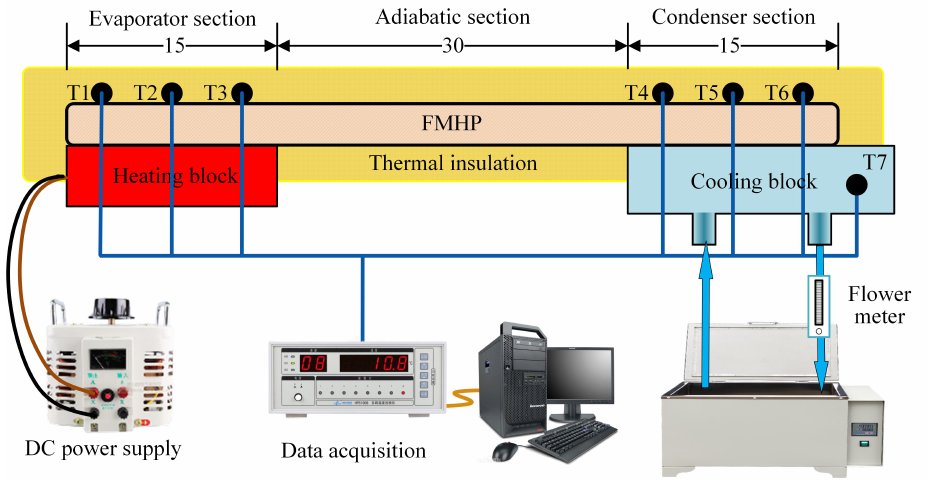
Figure 6. Diagram of the measurement system.